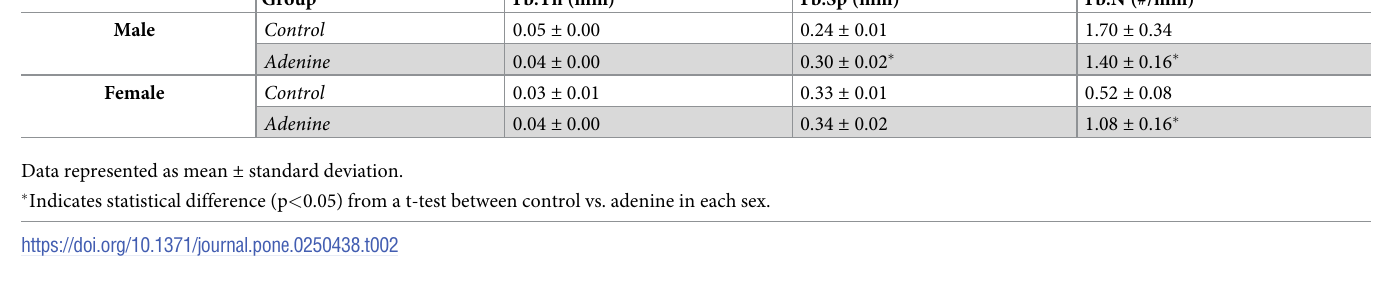
Table 2. Trabecular parameters from microCT of the distal femur.